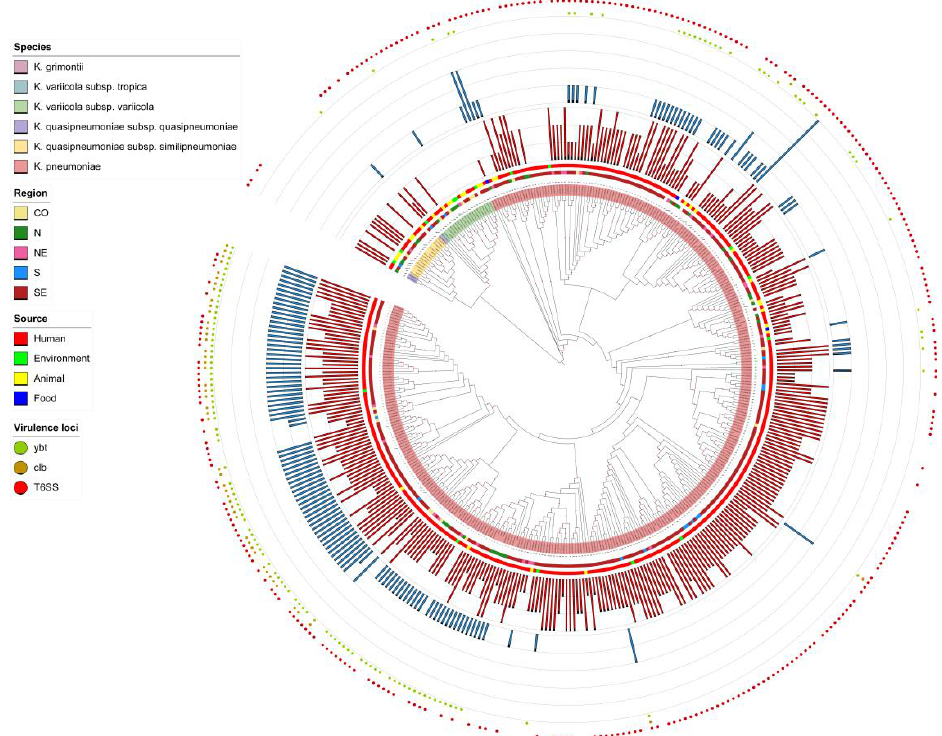
Figure 3. Maximum-likelihood tree based on the core genome of Klebsiella spp. The different species are indicated by the background colors of the accession numbers. The ST number of each genome is next to the accession number. There are two orbits of colored blocks, where the innermost represents the Brazilian regions from where the genome was obtained, and the outermost represents the source of isolation. More external to these blocks, the different sizes of the thin bars (0 to 5) indicate the antibiotic resistance (red) and virulence (blue) scores of the genomes. Outer-colored circles indicate genomes with complete operons of yersiniabactin (green), and colibactin (beige) loci; and the presence of Type VI secretion system gene clusters (red).